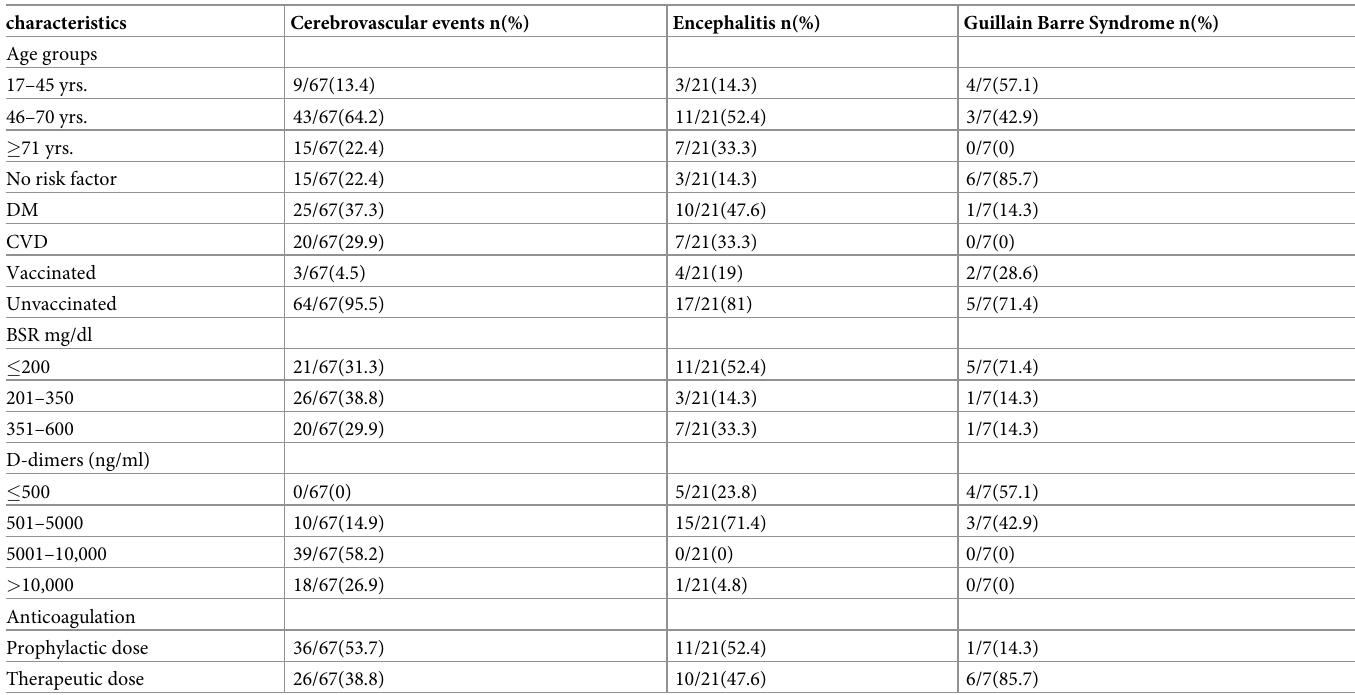
Table 3. Type of neurological complications and categorical variables.